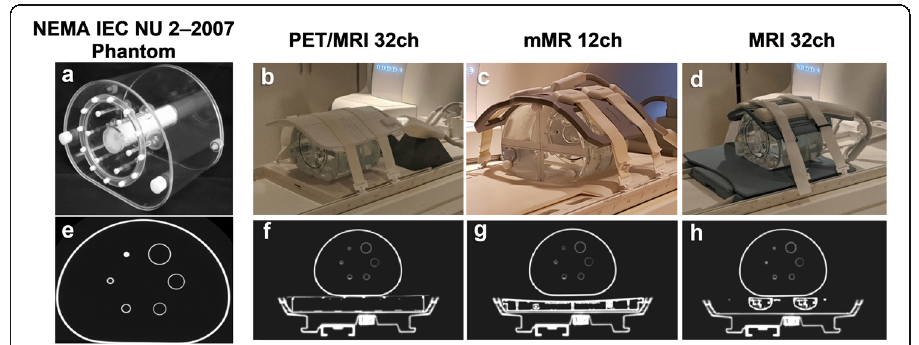
Fig. 1 NEMA body phantom ( a ) together with the novel PET/MRI 32ch, standard mMR12ch and MRI 32ch arrays ( b , c and d respectively). The DCTAC maps for each hardware showing here the axial central slice for the NEMA phantom with posterior view of PET/MRI 32ch, mMR12ch and MRI 32ch arrays ( e, f , g and h respectively). All u-maps are windowed to the same